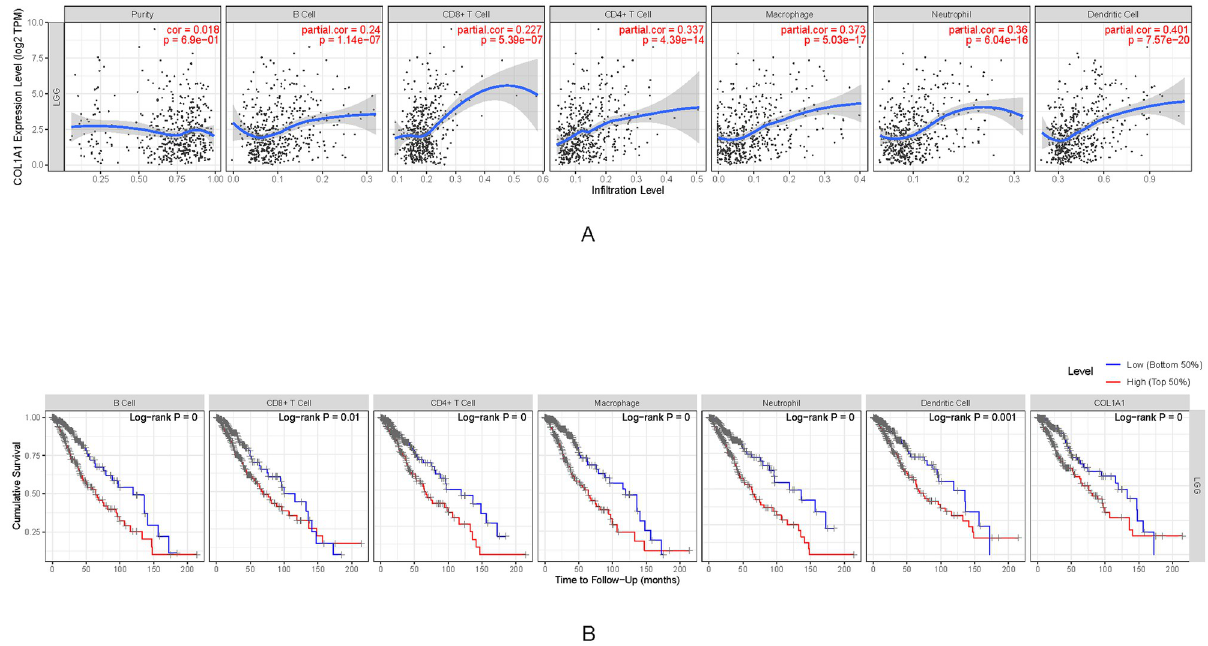
Fig 7. Immune infiltration level and survival time in LGG. A. Correlation of COL1A1 expression with infiltrating levels of B cell, CD4+ T cells, CD8 + T cells, Macrophages, Neutrophils and DCs in LGG. B. Cumulative survival of COL1A1 expression related to B cell, T cells, Macrophages, Neutrophils and DCs in